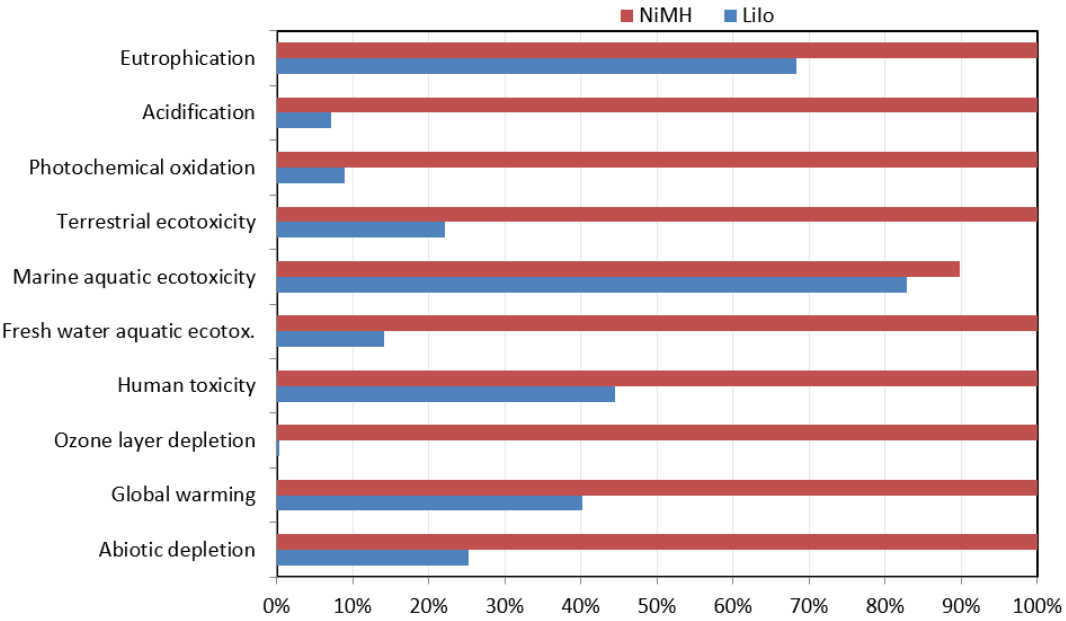
Figure 9. LCA outcome comparison per impact indicator, using the CML midpoint method.